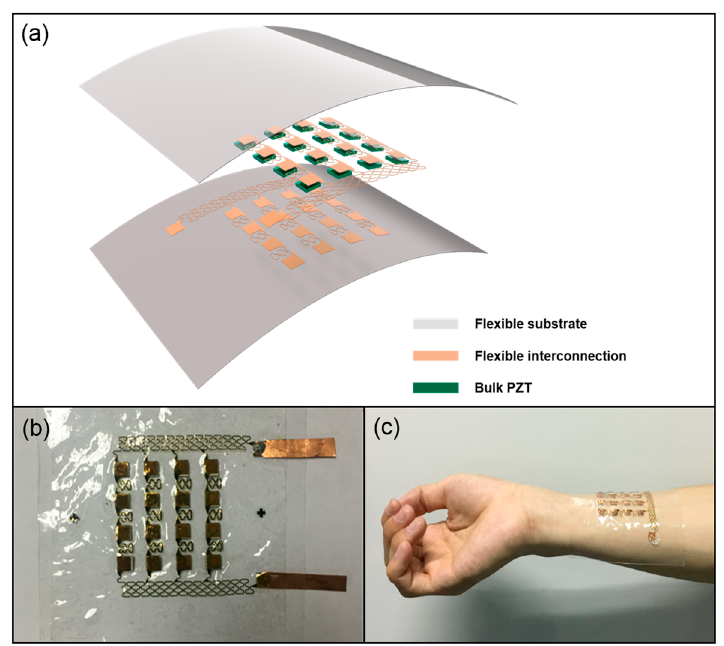
Figure 1. ( a ) Schematic drawing of the flexible piezoelectric micromachined ultrasonic transducer (FPMUT) array. ( b ) Photograph of the FPMUT array. ( c ) The FPMUT attached to skin of the arm.